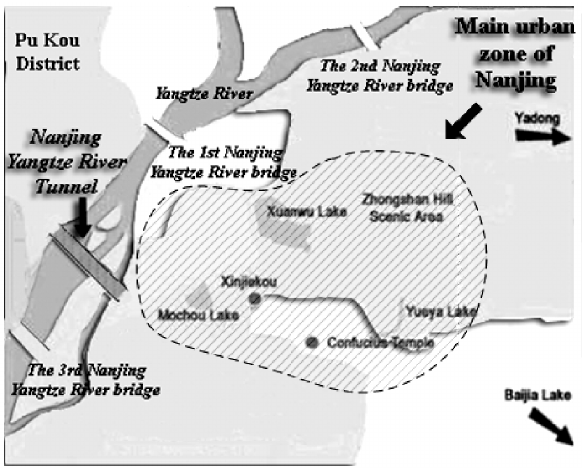
Fig. 3. The location of Nanjing Yangtze River Tunnel